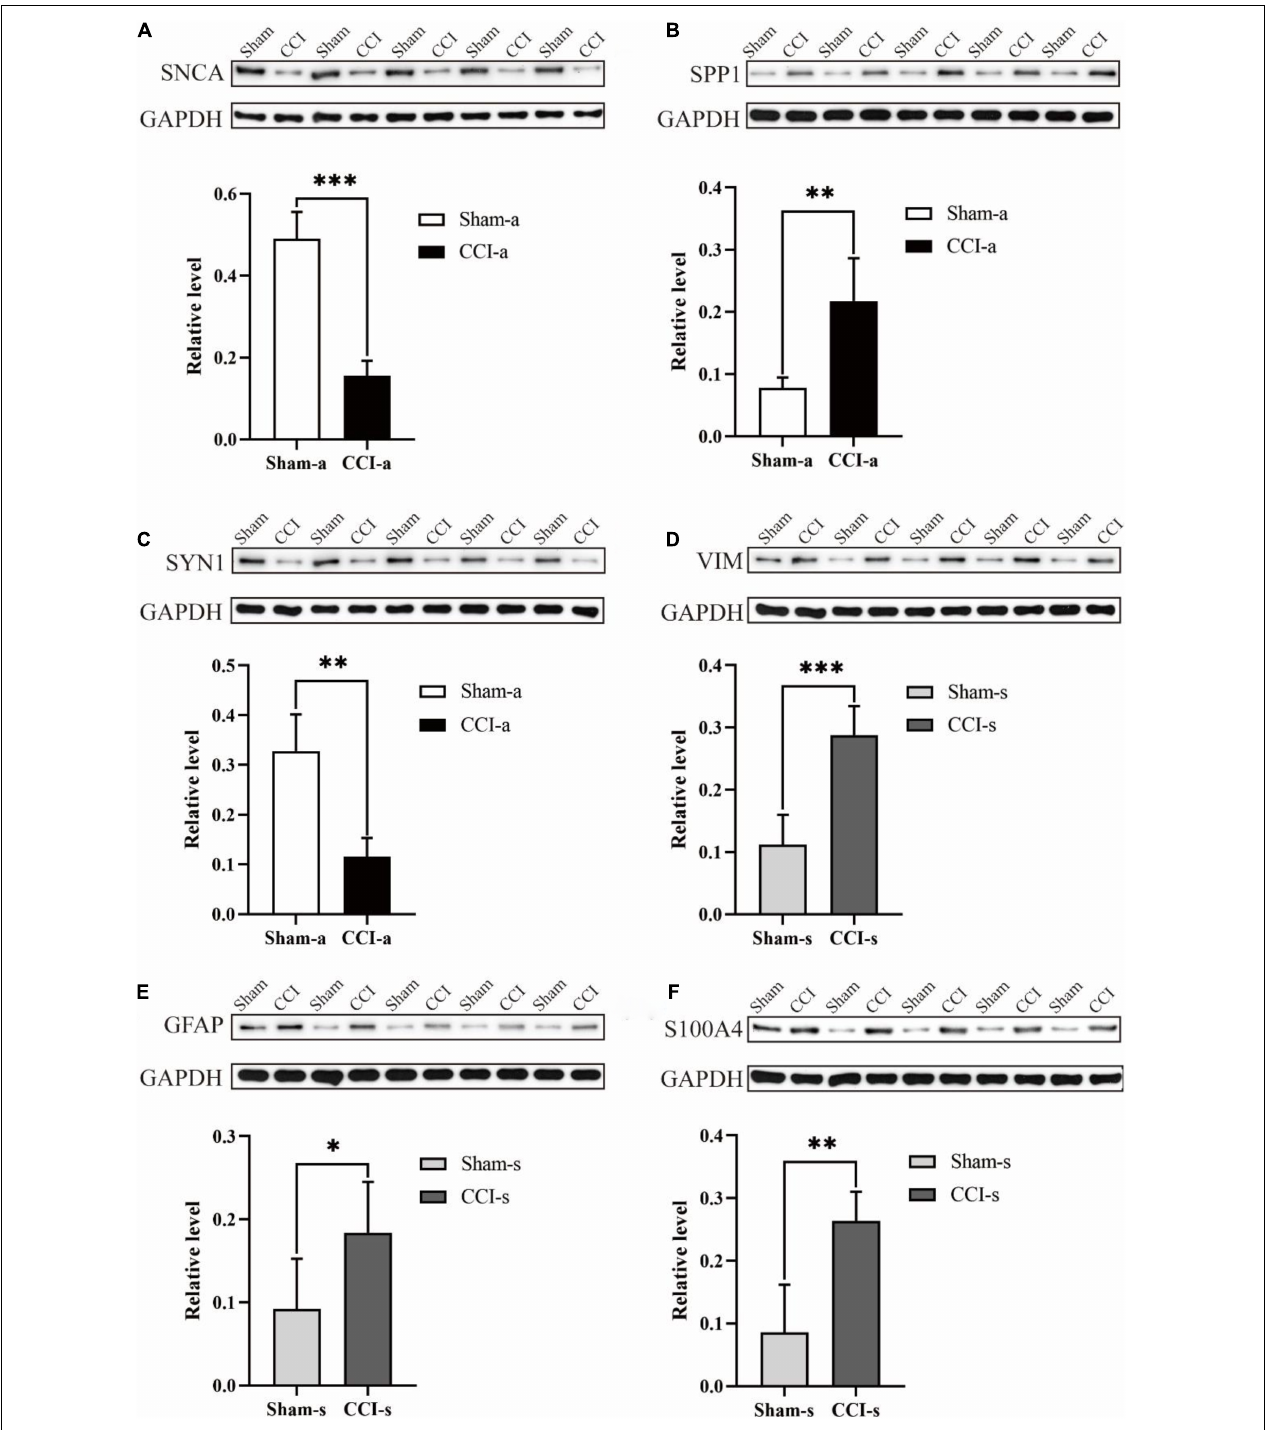
FIGURE 9 | Validation of randomly selected DEPs ( N = 5, data were expressed as mean ± SD. * p < 0.05; ** p < 0.01; *** p < 0.001). We randomly selected SNCA, SPP1, and SYN1 in Sham-a/CCI-a groups and VIM, GFAP, and S100A4 in Sham-s/CCI-s groups to verify. These were randomly selected from the top 20 up-regulated and down-regulated proteins, respectively. (A) Protein expression and relative level of SNCA. The experiment was repeated five times with similar results. (B) Protein expression and relative level of SPP1. The experiment was repeated five times with similar results. (C) Protein expression and relative level of SYN1. The experiment was repeated five times with similar results. (D) Protein expression and relative level of VIM. The experiment was repeated five times with similar results. (E) Protein expression and relative level of GFAP. The experiment was repeated five times with similar results. (F) Protein expression and relative level of S100A4. The experiment was repeated five times with similar